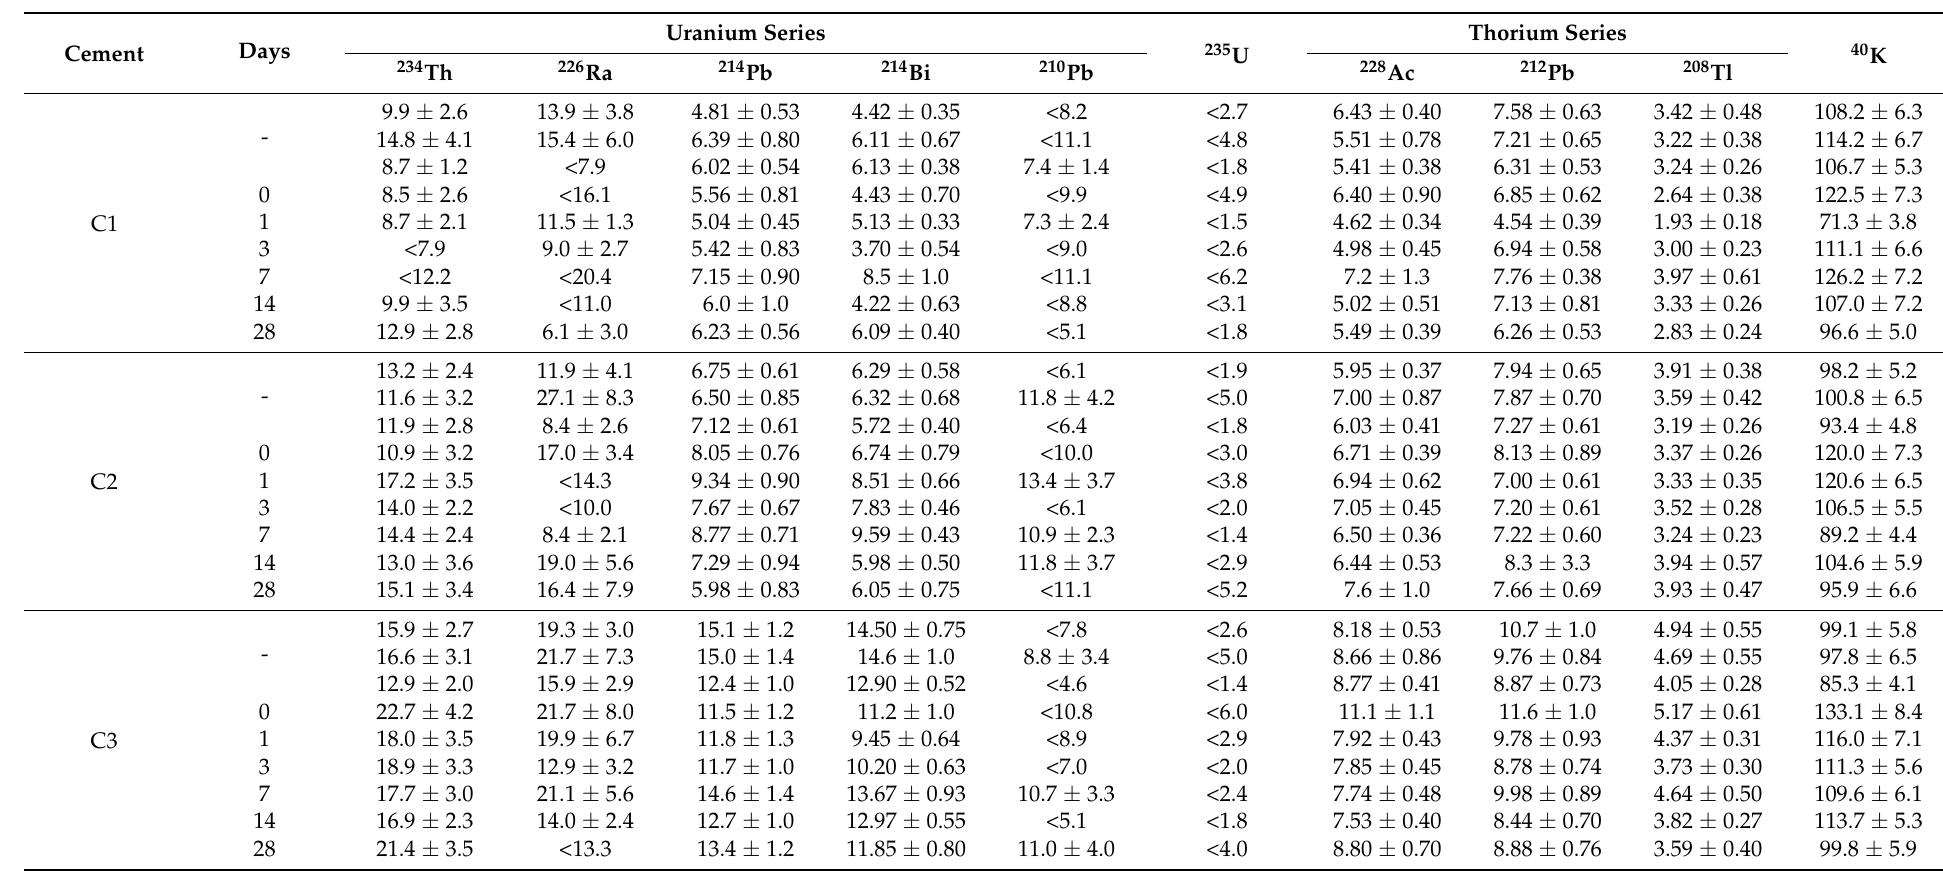
Table 1. Activity concentrations of the prisms of hardened mortars (The prisms were ground to measure the activity concentrations): (a) non-carbonated